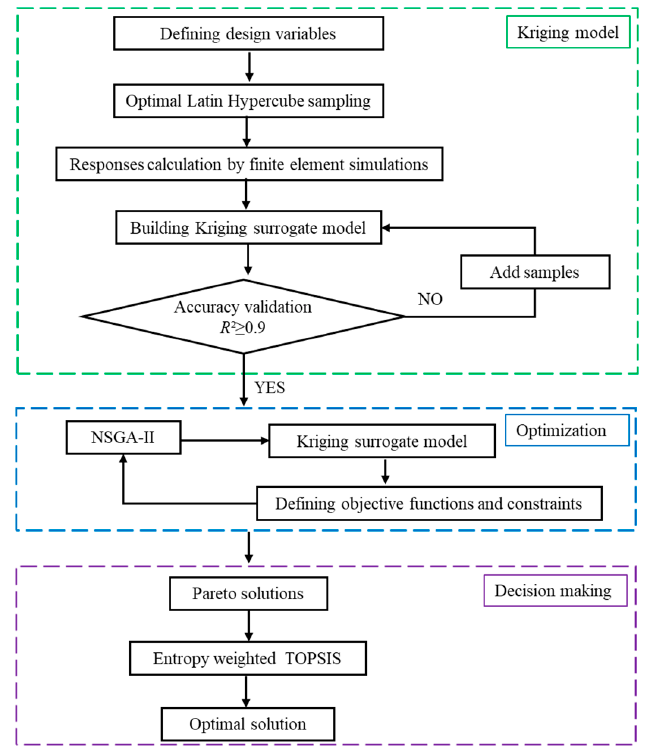
Figure 2. Flow chart of the proposed multi-objective optimization procedure.